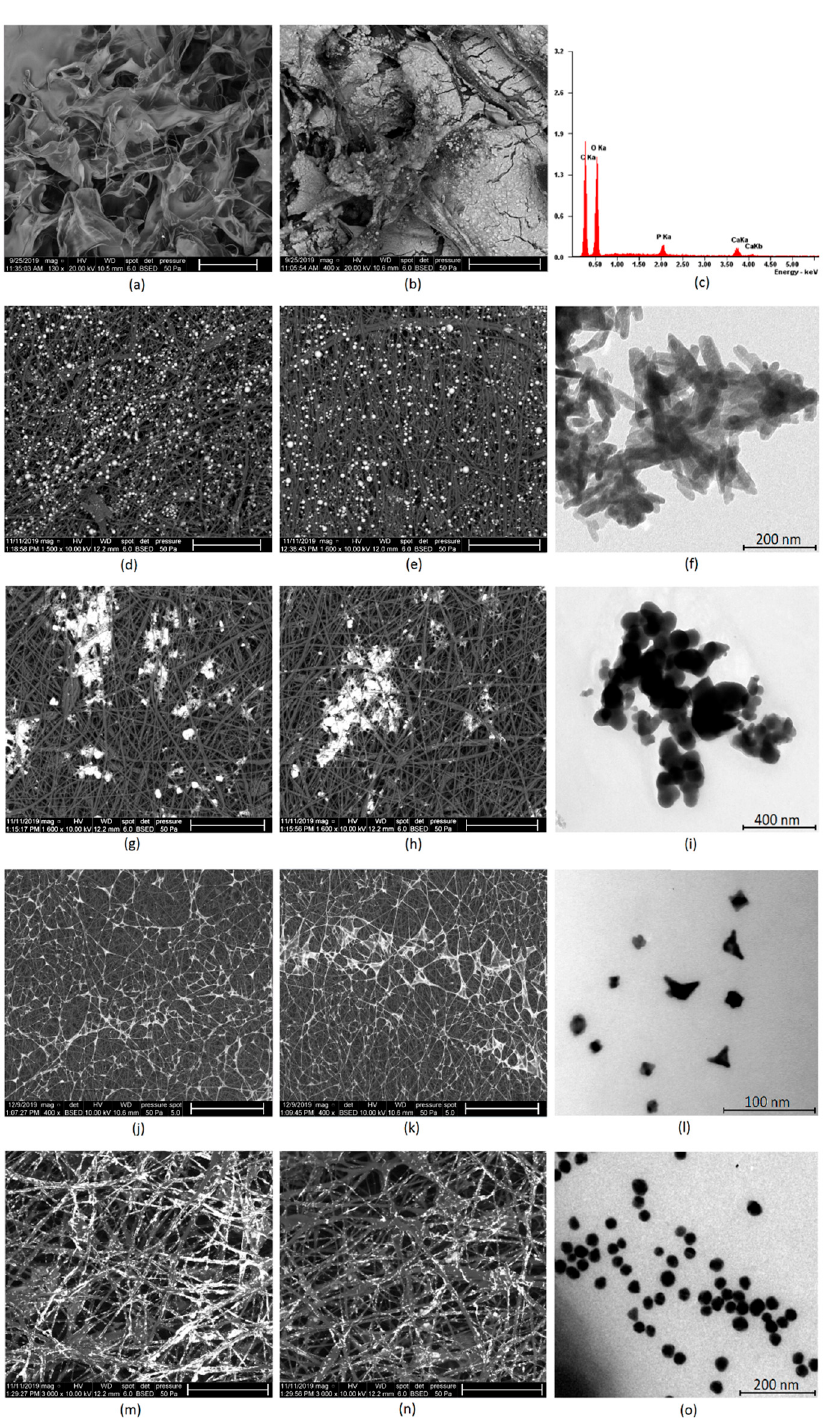
Figure 7. ( a ) SEM microphotograph of the pure chitosan scaffold (scale bar 500 µm); ( b ) SEM microphotograph of the chitosan scaffolds modified with HA nanoparticles (scale bar 200 µm); ( c ) elemental analysis of the scaffold composition; ( d ) SEM microphotograph of the PLA nanofibers obtained under 30kV covered with HA particles (scale bar 50 µm); ( e ) SEM microphotograph of the PLA nanofibers obtained under 35kV covered with HA particles (scale bar 50 µm); ( f ) TEM microphotograph of the prepared HA nanoparticles; ( g ) SEM microphotograph of the PLA nanofibers obtained under 30 kV covered with TiO 2 nanoparticles (scale bar 50 µm); ( h ) SEM microphotograph of the PLA nanofibers obtained under 35kV covered with TiO 2 nanoparticles (scale bar 50 µm); ( i ) TEM microphotograph of the prepared TiO 2 nanoparticles; ( j ) SEM microphotograph of the PLA nanofibers obtained under 30 kV covered with Pt nanoparticles (scale bar 50 µm); ( k ) SEM microphotograph of the PLA nanofibers obtained under 35 kV covered with Pt nanoparticles (scale